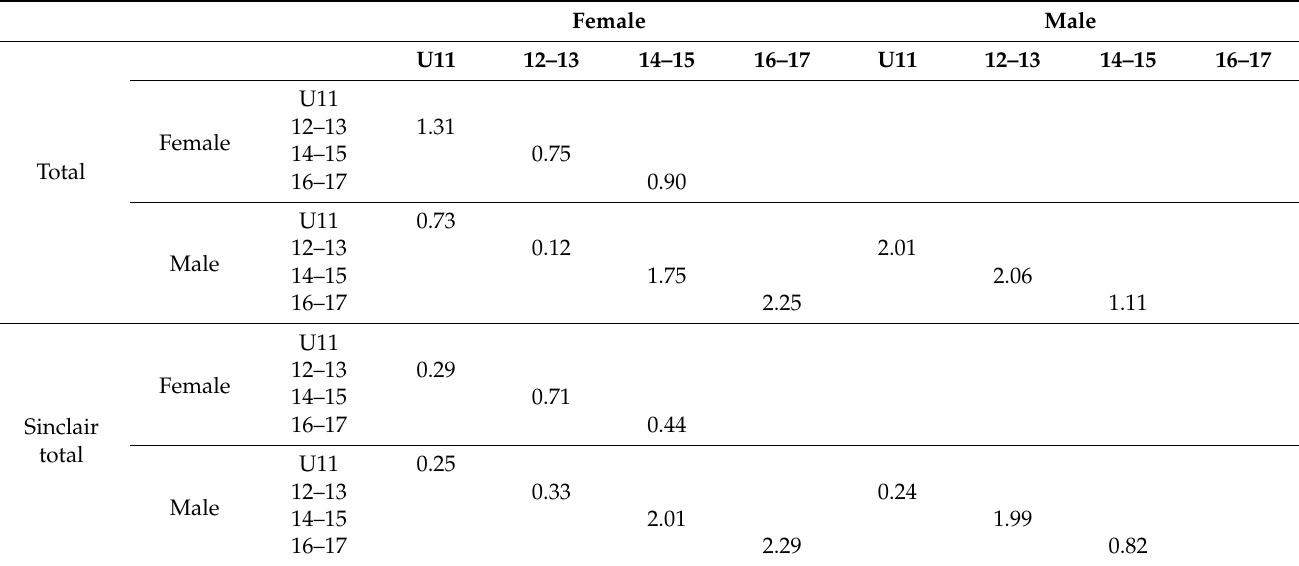
Figure 2. Comparisons of Sinclair total between age groups and sexes. U11 = 11 and under. 12–13 = age group of 12 and 13-year-olds. 14–15 = age group of 14 and 15-year-olds. 16–17 = age group of 16 and 17-year-olds. The error bars indicate standard deviations. A statistically significant interaction effect was found for sex by age group overall. A statistically significant first-order polynomial trend was found for male and female. A statistically significant simple comparison was found between 12–13 and 14–15 for male. A statistical simple comparison between male and female for 16–17. Table 3. Cohen’s d for simple Table 2. Mean differences between age groups within a sex.